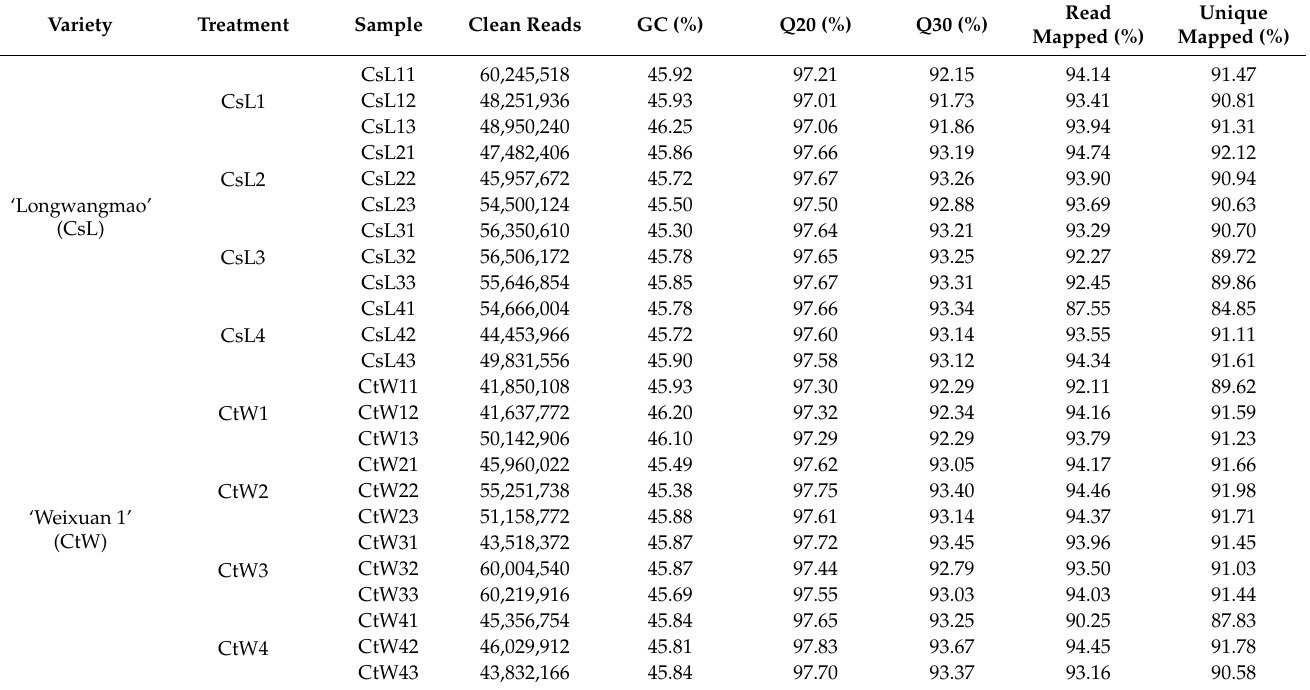
Table 1. Summary of mapping transcriptome reads to reference